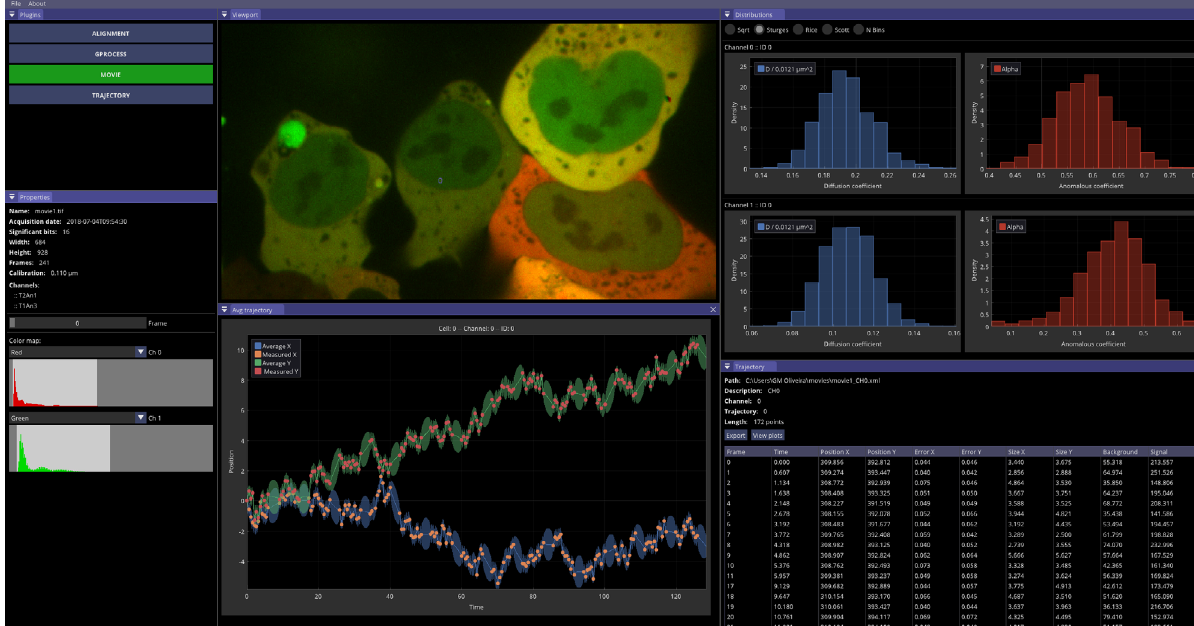
Fig. 5 GP-Tool: A graphical user interphase to apply GP-FBM on microscopy movies. Viewport displays movie under analysis. The distributions are estimations of the posterior distribution for D α and α via Metropolis-Hasting sampling. Trajectory tab displays detections with enhanced localization and other important parameters such as estimated localization error, particle size and signal. The average trajectory tab displays interpolated curves with the most probable path taken by the particle with a 95% credible